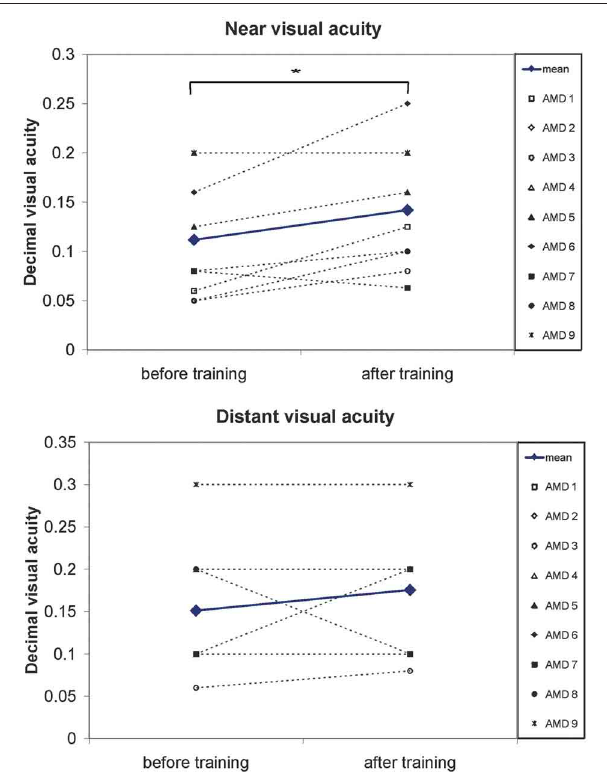
FIGURE 5 | A significant increase in visual acuity after the 6 months of training was observed. Pairwise comparisons show a significant increase in near visual acuity ( p = 0 . 03) but not for distant visual acuity ( p = 0 . 3). Symbols, connected with dotted lines, show the values of individual patients, blue lines show the mean values over all